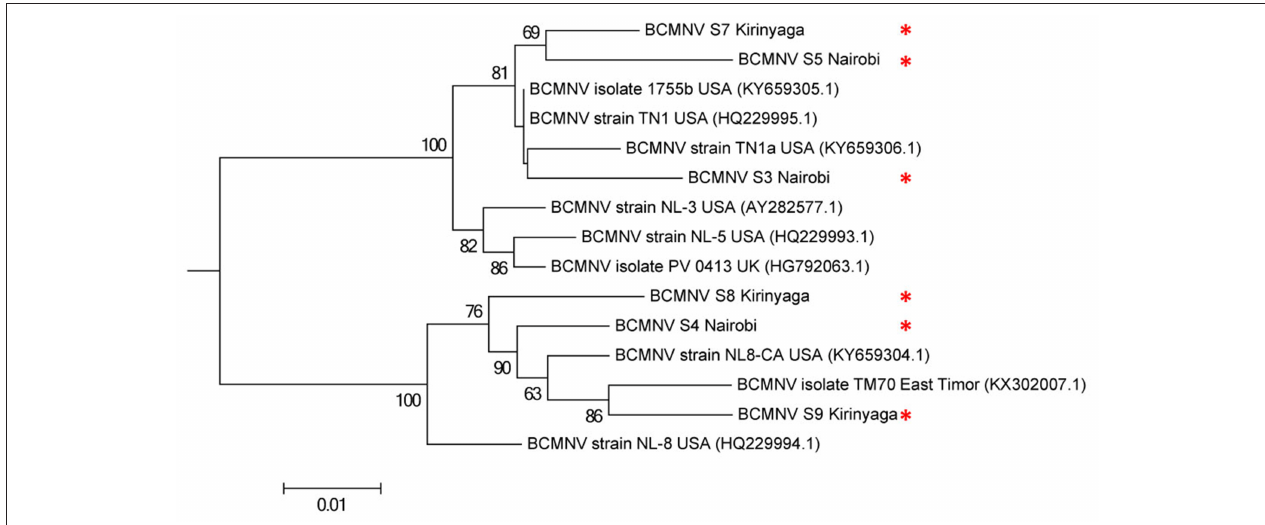
FIGURE 2 | Phylogenetic analysis of six bean common mosaic necrosis virus (BCMNV) isolates from Kabete (Nairobi University Research Farm) and farms in Kirinyaga County with other BCMNV isolates and strains. The phylogeny was based on aligning 312 amino acid bases of the P1 protein. The evolutionary history was inferred by using the Maximum likelihood method based on the Jones-Taylor-Thornton matrix based model with 1,000 bootstraps in MEGA version 6. Viral isolates identified in this study are indicated by *.